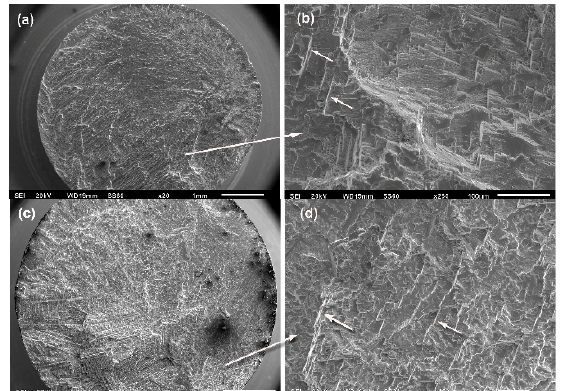
Figure 4. Fracture surfaces of alloys without B (arrows indicate striations): ( a , b ) 0B-AC alloy after 1,041,310 cycles at 541 MPa; ( c , d ) 0B-HT alloy after 3,879,407 cycles at 615 MPa; non-metallic inclusions can be seen in ( c ).